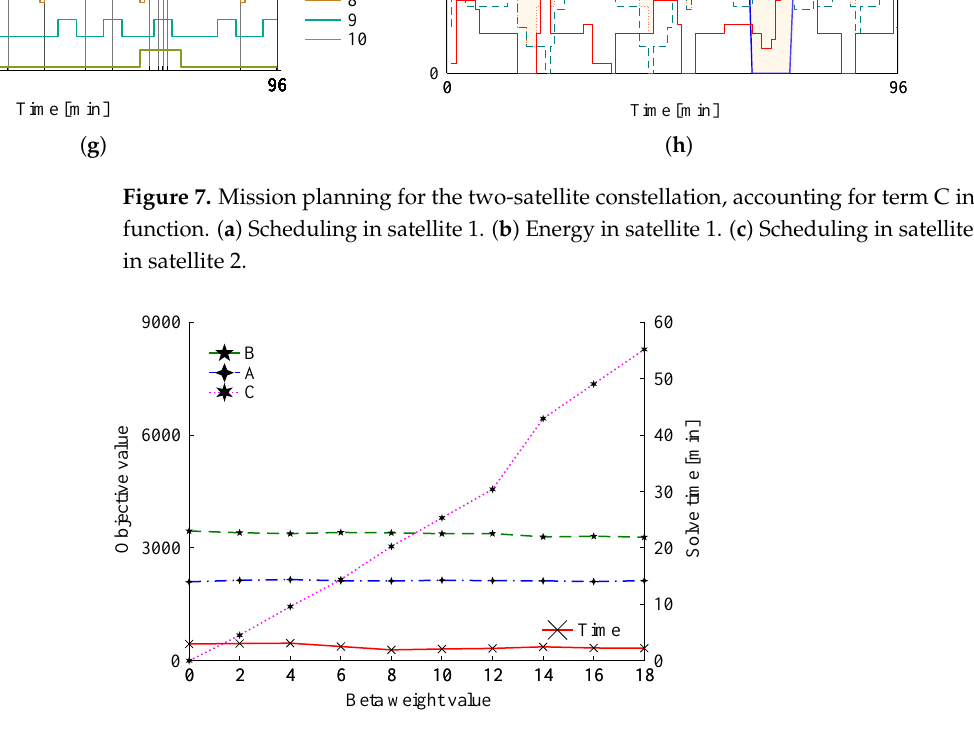
Figure 8. Collective (A), individual (B) and redundancy (C) objective values, and the respective solving time, for the constellation with two satellites, solved with different weight values for the objective term